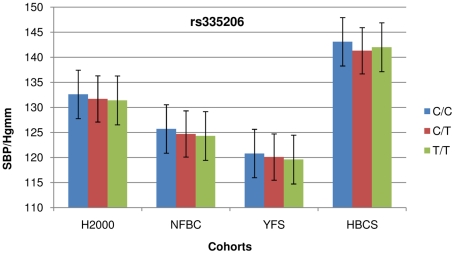
Cohort-wise effects of risk allele count on SBP.The higher median age in HBCS is reflected as higher systolic blood pressure (SBP) and less consistent association. Error bars show standard error.